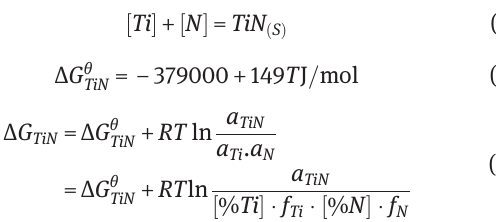
Figure 1: Gibbs free energy of the reaction between nitrogen, oxygen, and